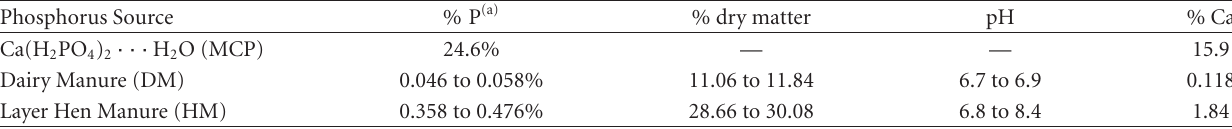
Table 2: Properties of Phosphorus